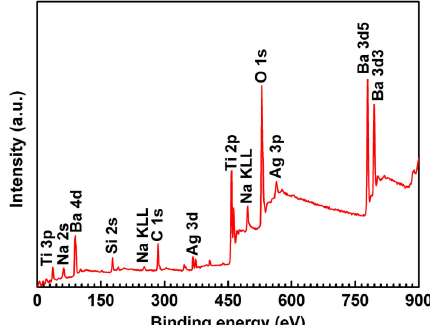
Fig. 3 XPS survey scan spectra of the Ag 25 /BTO thin film.